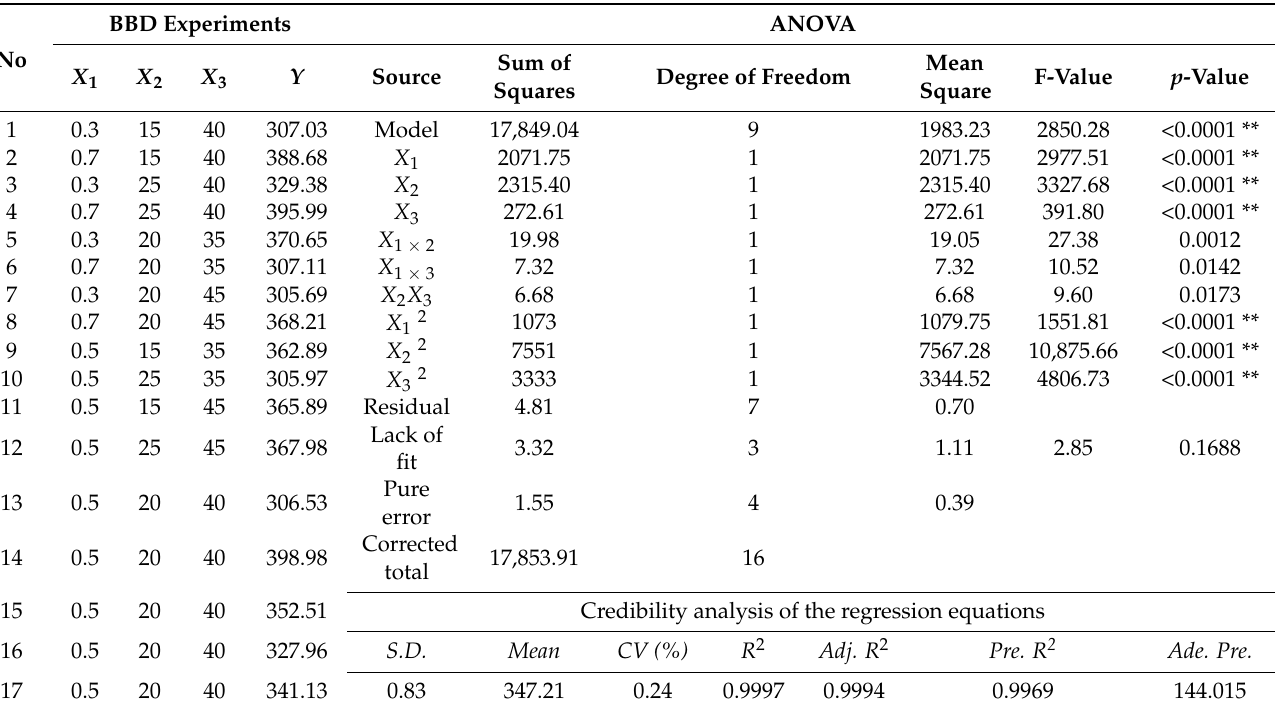
Table 2. Box–Behnken design (BBD) with the experimental value for NUP size (nm), analysis of variance (ANOVA) for the response surface quadratic model, and fit statistics for the response